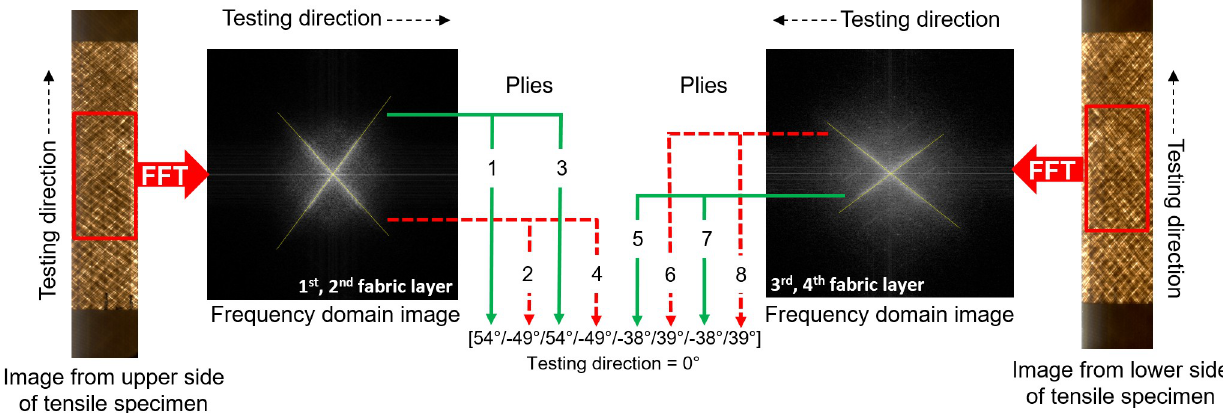
Fig 6. Illustration of the Fast Fibre Orientation (FFO) method for measurements of yarn orientation in a tensile specimen of a multiaxial composite. Shown is an example of a composite with fabric I, and with layup A.